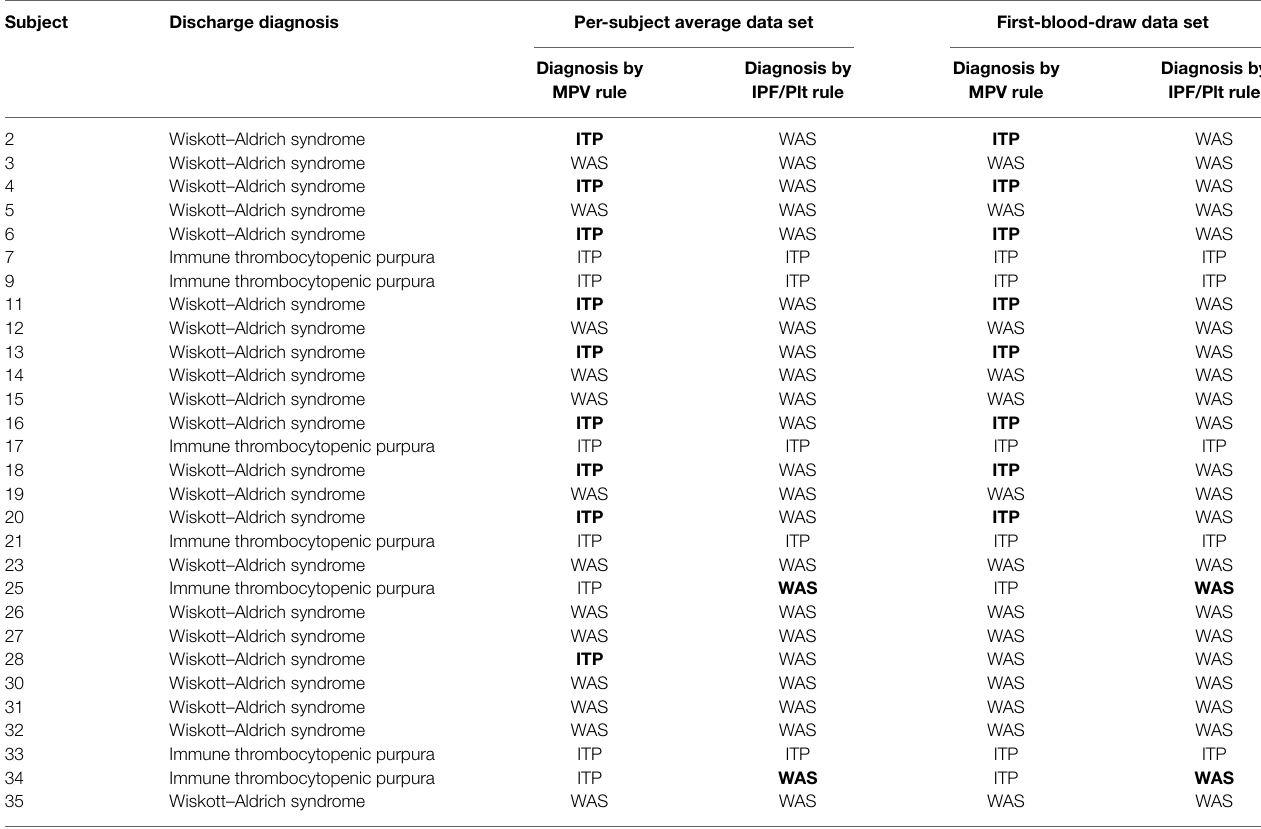
TABLE 5 | Discharge diagnoses and diagnoses determined by the MPV rule or by the IPF/PLT rule for the validation cohort .